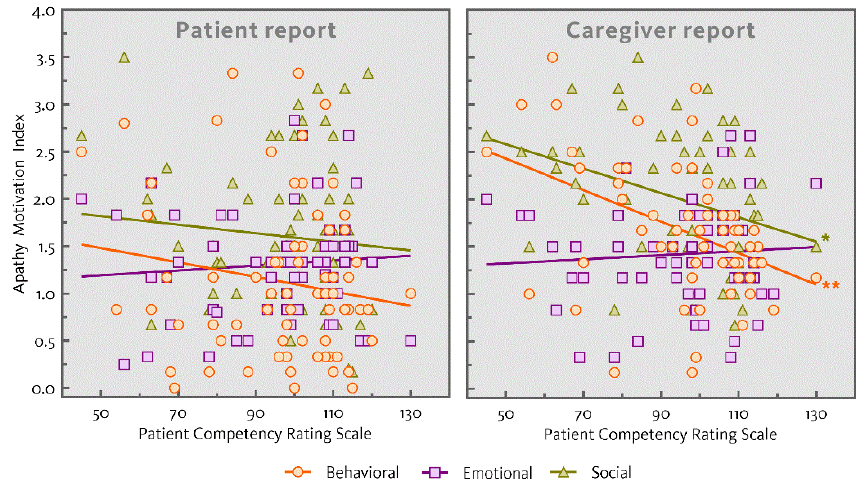
Figure 2. Scatterplots (with regression lines) showing the correlations between the patient and caregiver reports for the subscales of the apathy motivation index and the patient competency rating scale (* p < 0.05, ** p < 0.01).